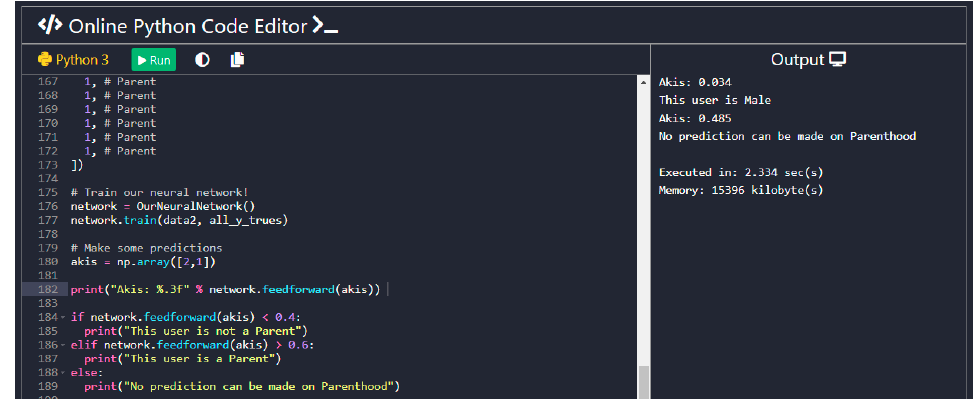
Figure 7. Prediction for a user. This user is a Male and a no prediction can be made for his parenthood, so probably he is not a parent.